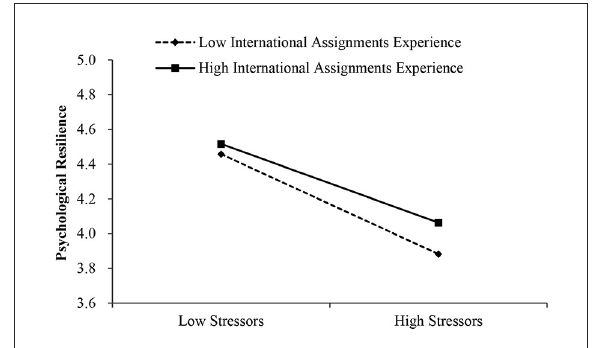
FIGURE3 Simple slopes of international assignments experience moderate the relationship between stressors during COVID-19 and psychological resilience.